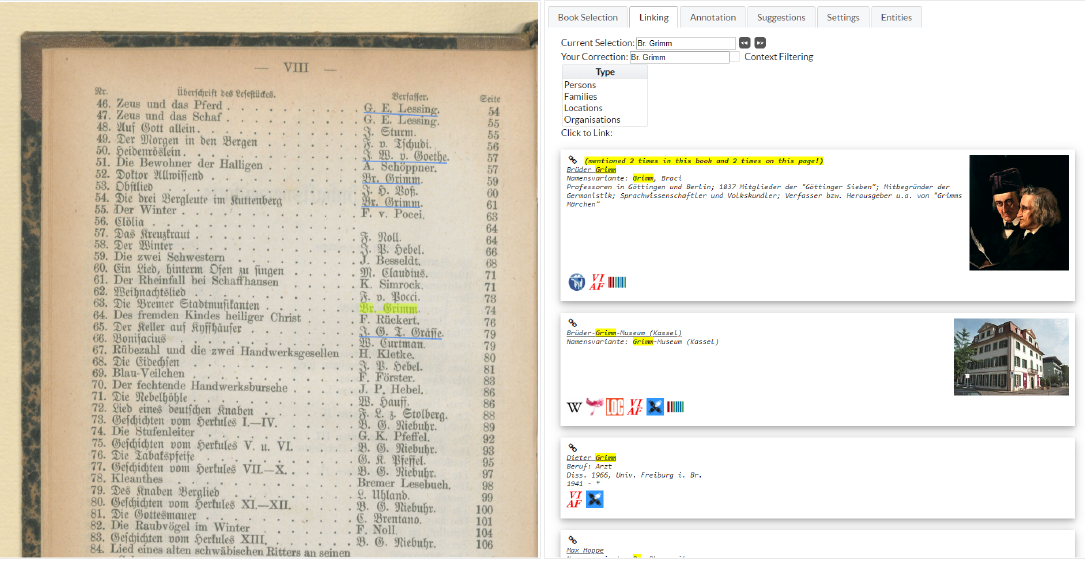
Figure 5. Screenshot of the SemKoS entity linking